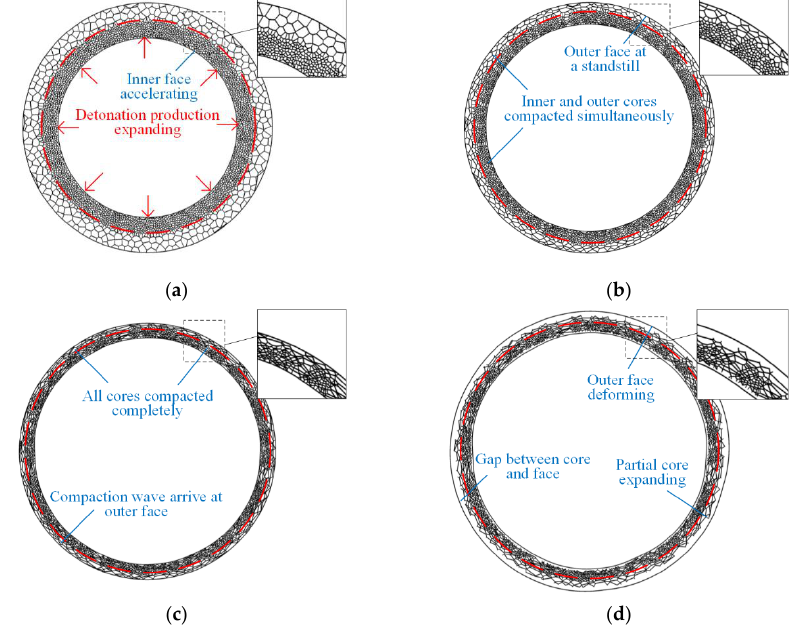
Figure 14. FE results of sandwich rings with negative gradient core. ( a ) First phase, ( b ) second phase, ( c ) end of second phase, and ( d ) third phase.